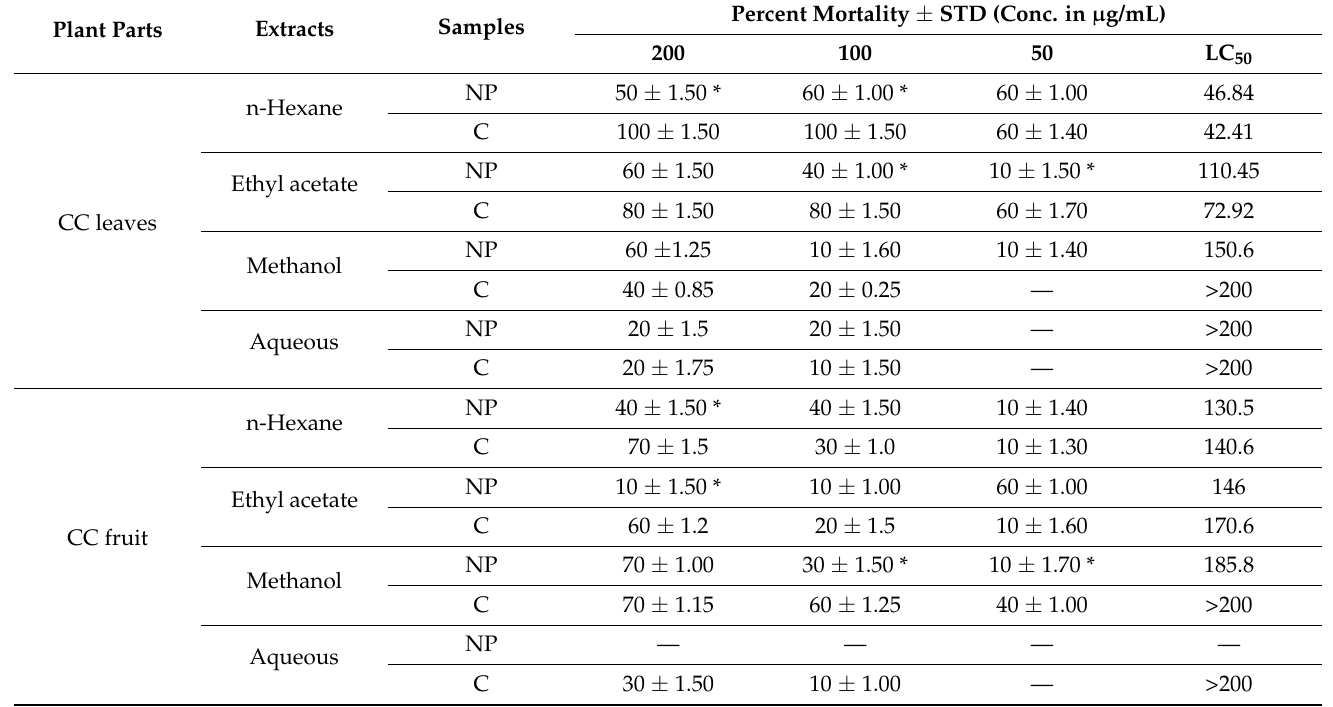
Table 4. Cytotoxicity potential of crude extracts and nanoparticles of leaves and fruits of C. colocynthis . Plant